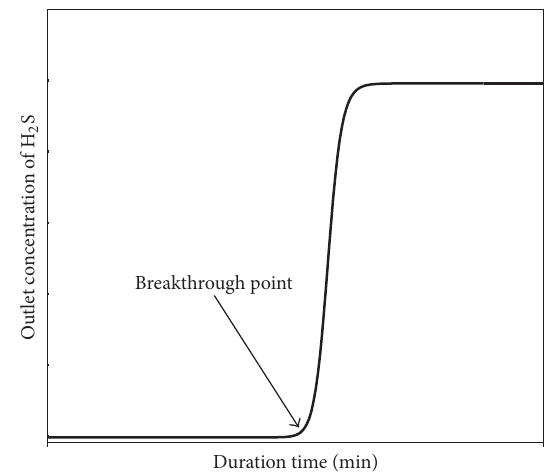
Figure 1: The typical H 2 S breakthrough curve and breakthrough